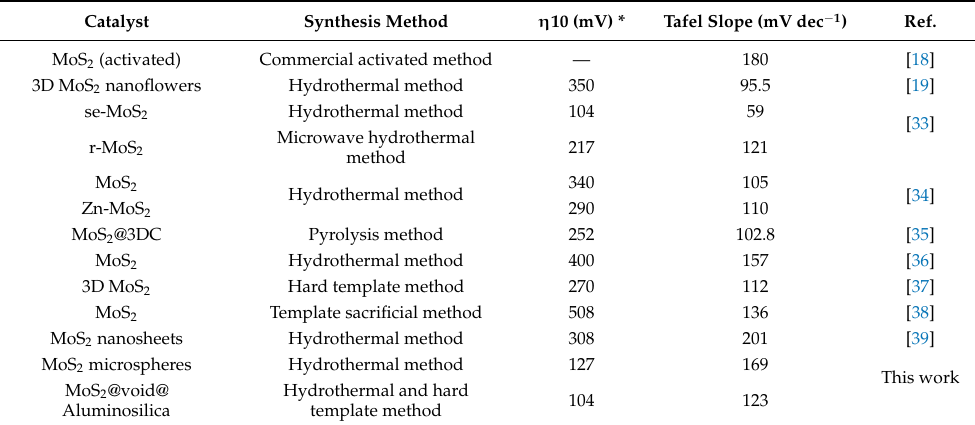
Table 2. The synthesis method and HER performance of the MoS 2 -based electrocatalysts.